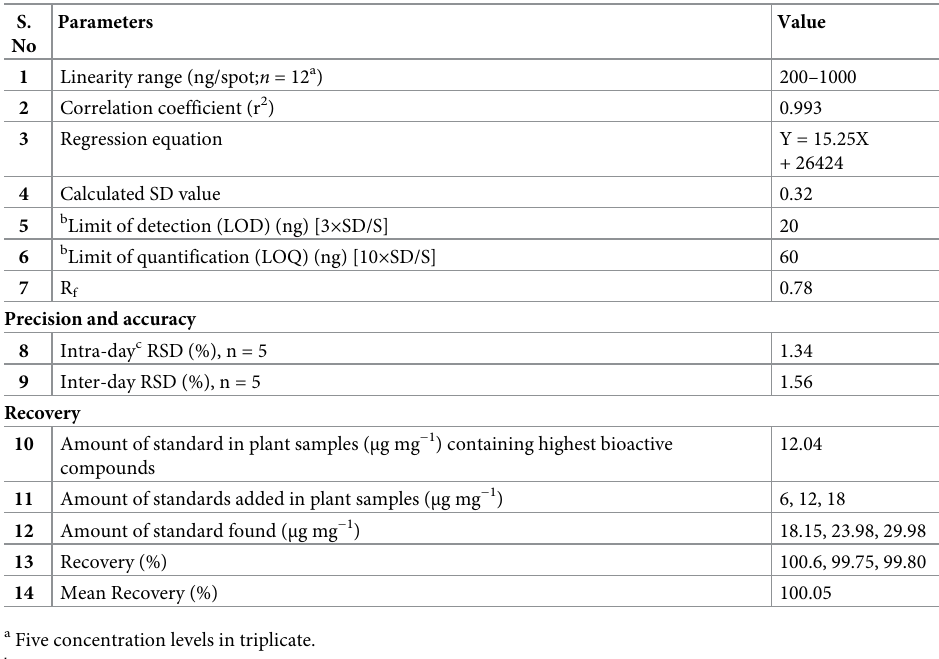
Table 1. Method validation for diosgenin